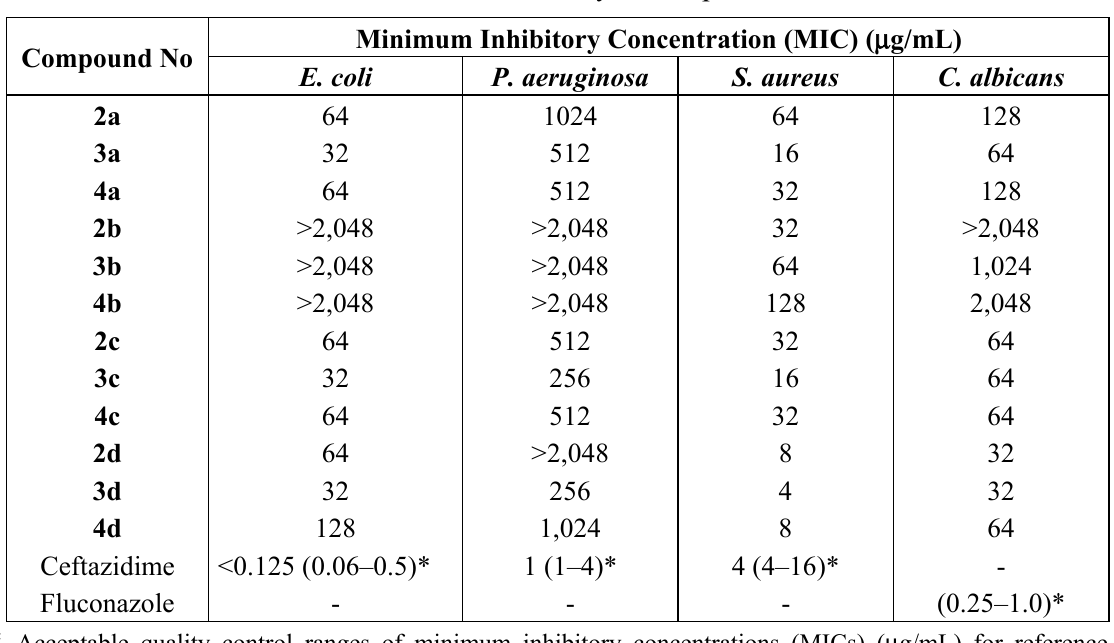
Table 1. Antimicrobial activity of compounds 2a – 4d